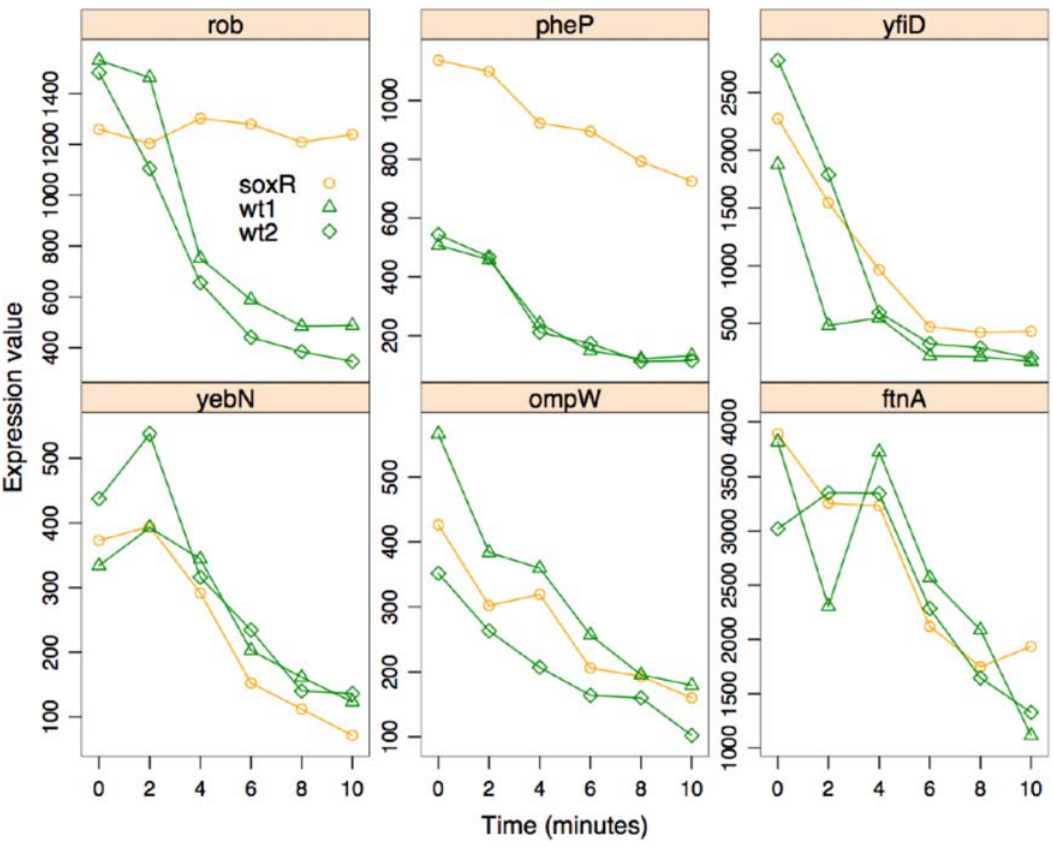
Figure 4. Down-regulated Genes. Each graph shows changes in the expression values of each individual gene in cluster 14.